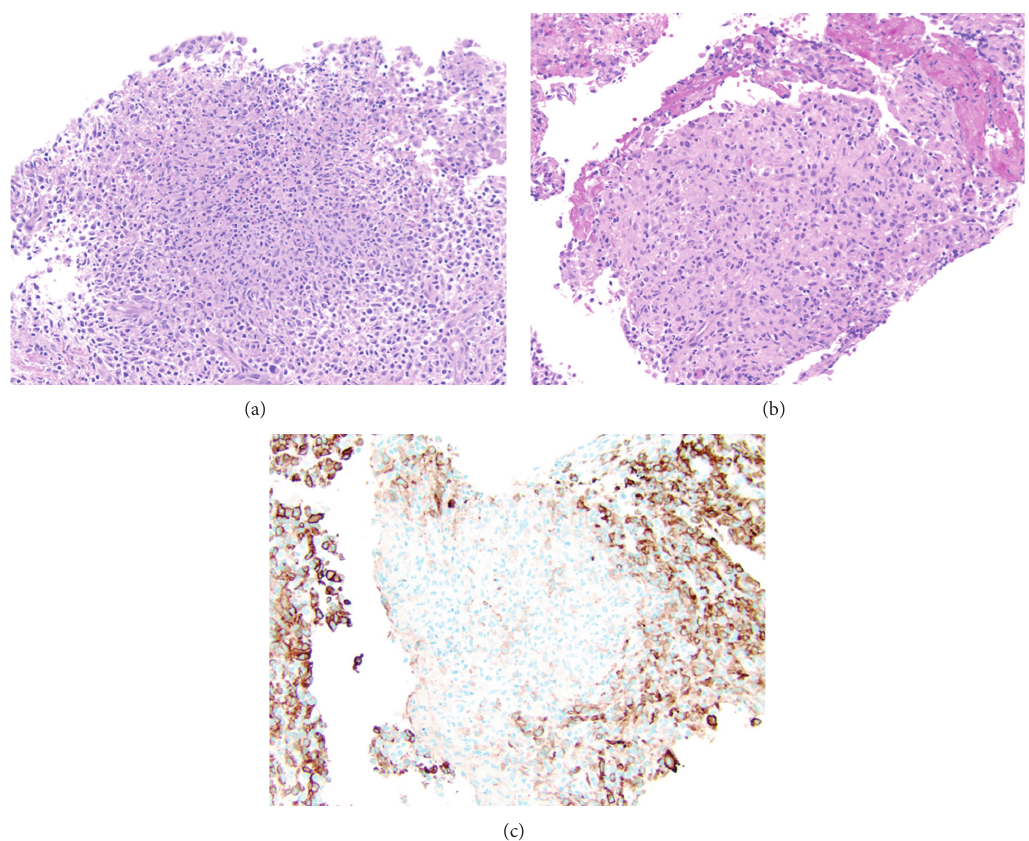
Figure 1: (a) Biopsy of peritoneal nodules demonstrated a cellular and organizing peritonitis including neutrophils, mesothelial cells, and abundantmacrophagessomewithepithelioidfeatures(HE,200x).Focalareashadrelativelywell-organizedgranulomas(b)withmacrophages that did not express the activated macrophage marker CD163 (c) ((b); HE, 200x, (c); CD163,